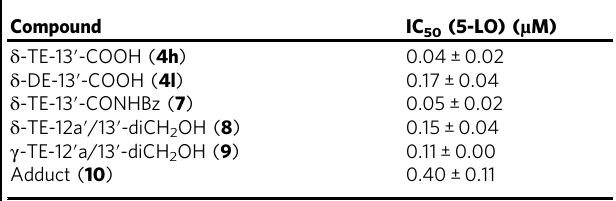
Table 2 IC 50 values of LCMs for inhibition of puri fi ed human recombinant 5-LO